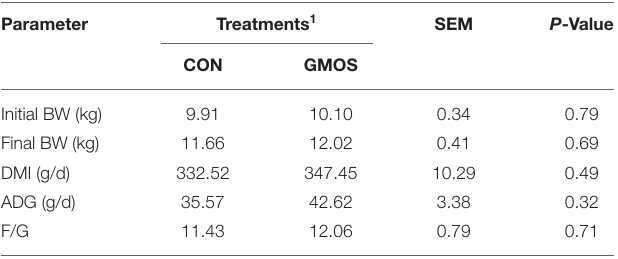
TABLE 2 | Effects of dietary supplementation of GMOS on growth performance in